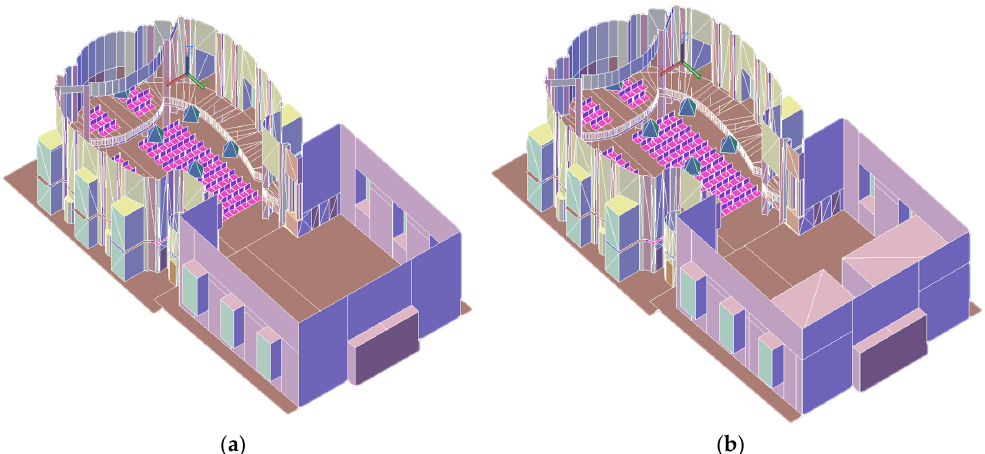
Figure 8. The 3D model of the Eszterháza Opera House in Scenarios 1 and 2 ( a ), and the 3D model of the Eszterháza Opera House in Scenario 3 ( b ).